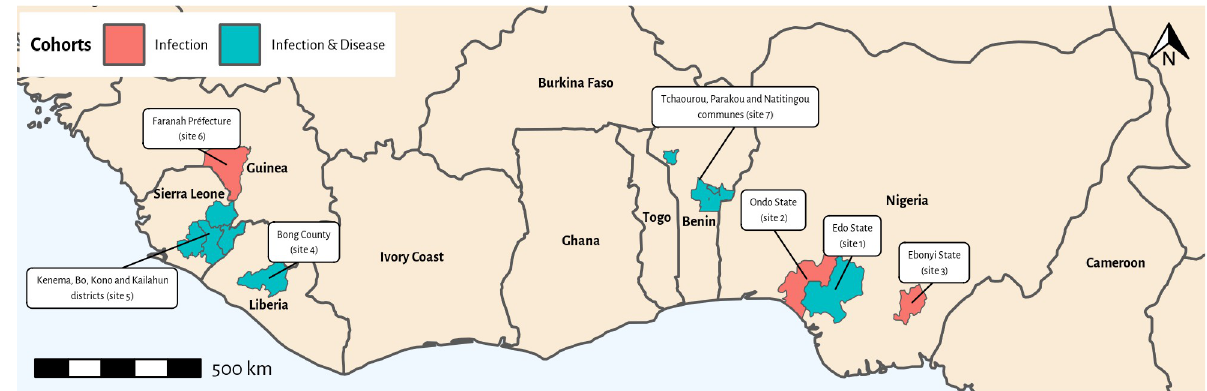
Fig 2. Map of study